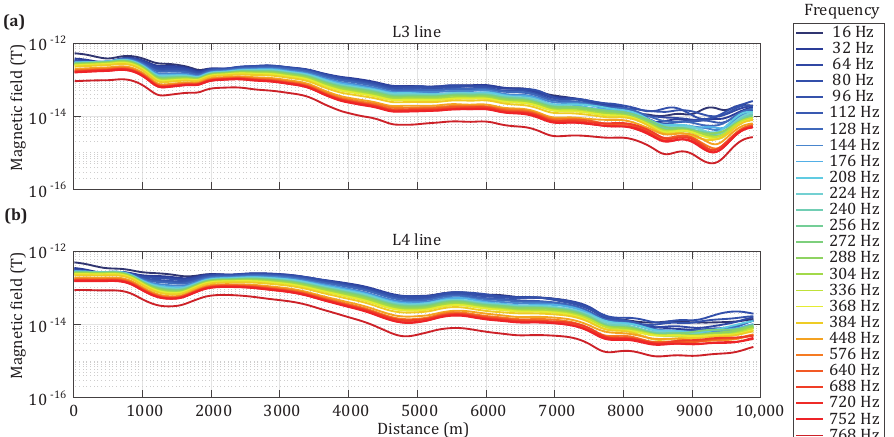
Figure 6. Field measured data of the GAFEM system. ( a ) L3 line. ( b ) L4